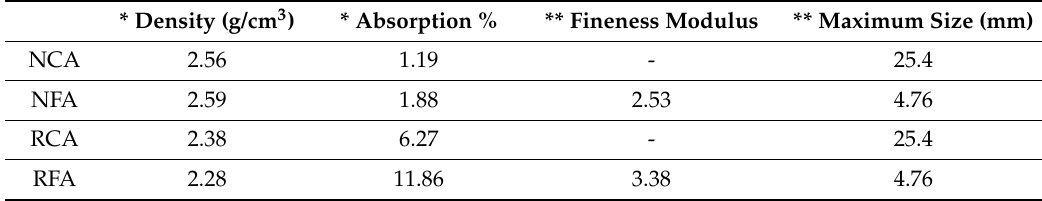
Table 2. Physical characteristics of the